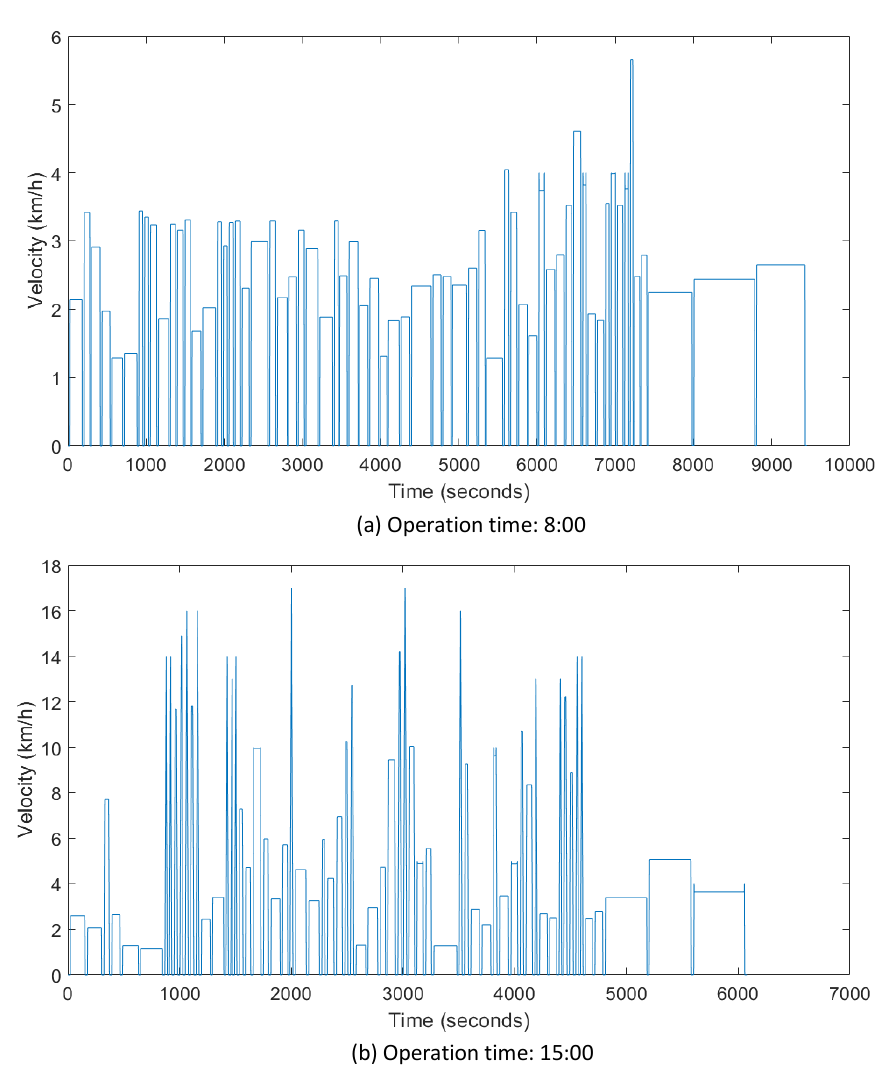
Figure 4. Velocity data based on operational timeline. ( a ) Operation time: 8:00; ( b ) Operation time: